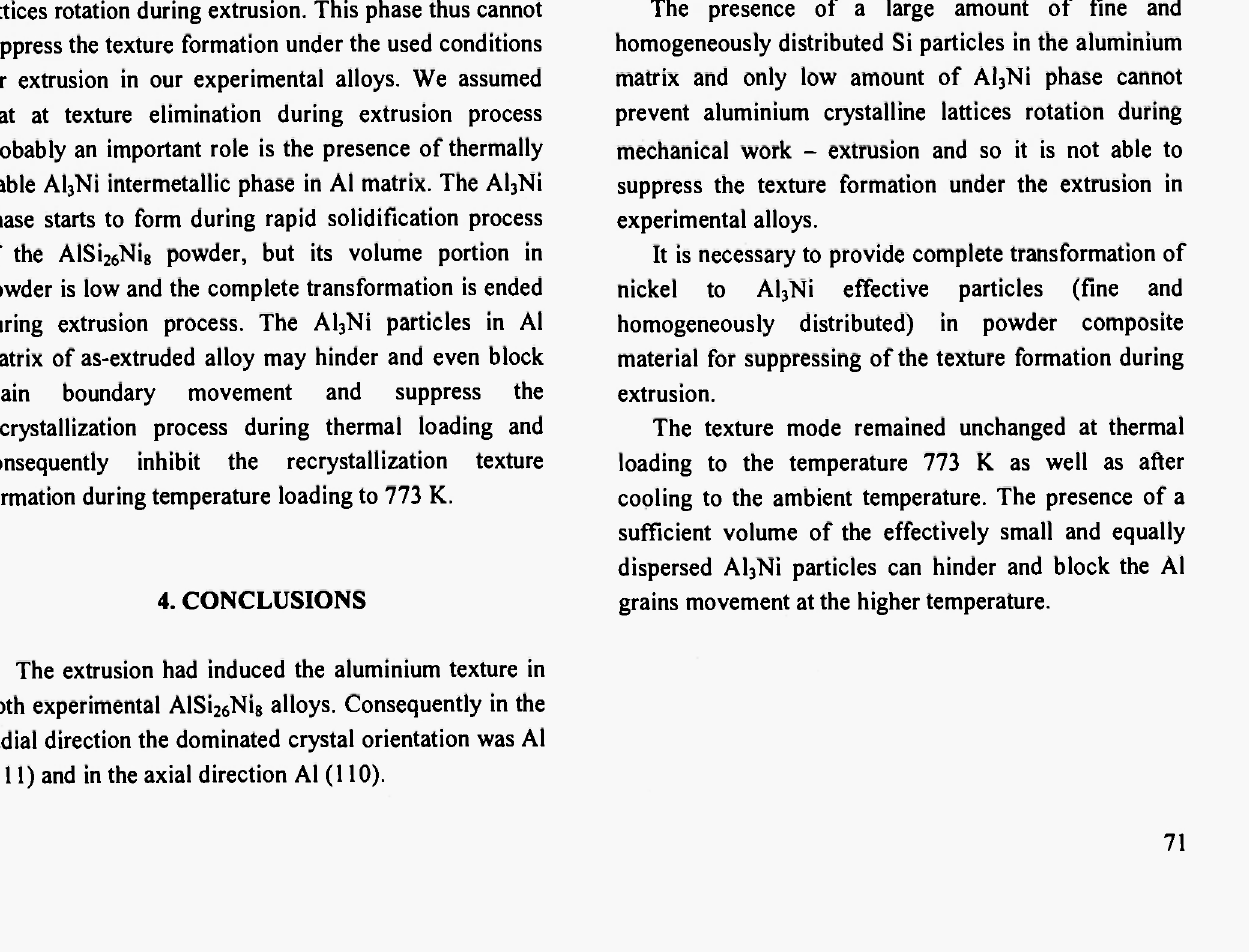
Fig. 8a, b: Comparison of the diffraction lines course of the as-extruded AlSi 2 6Ni 8 material φ 40 mm scanned at different